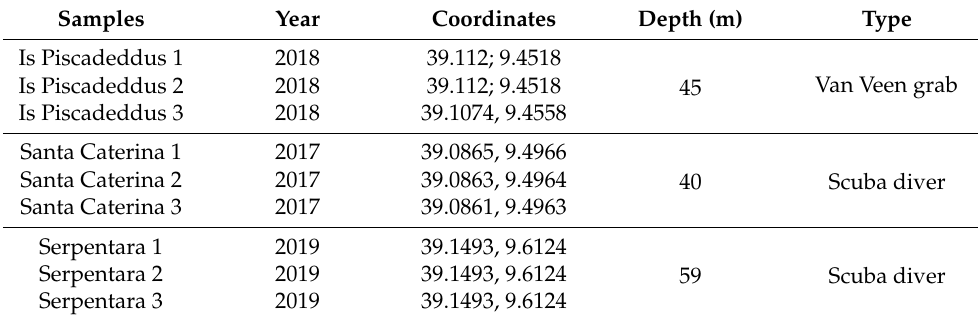
Table 1. List of samples, with the indication of the year of collection, coordinates, depth, and type of